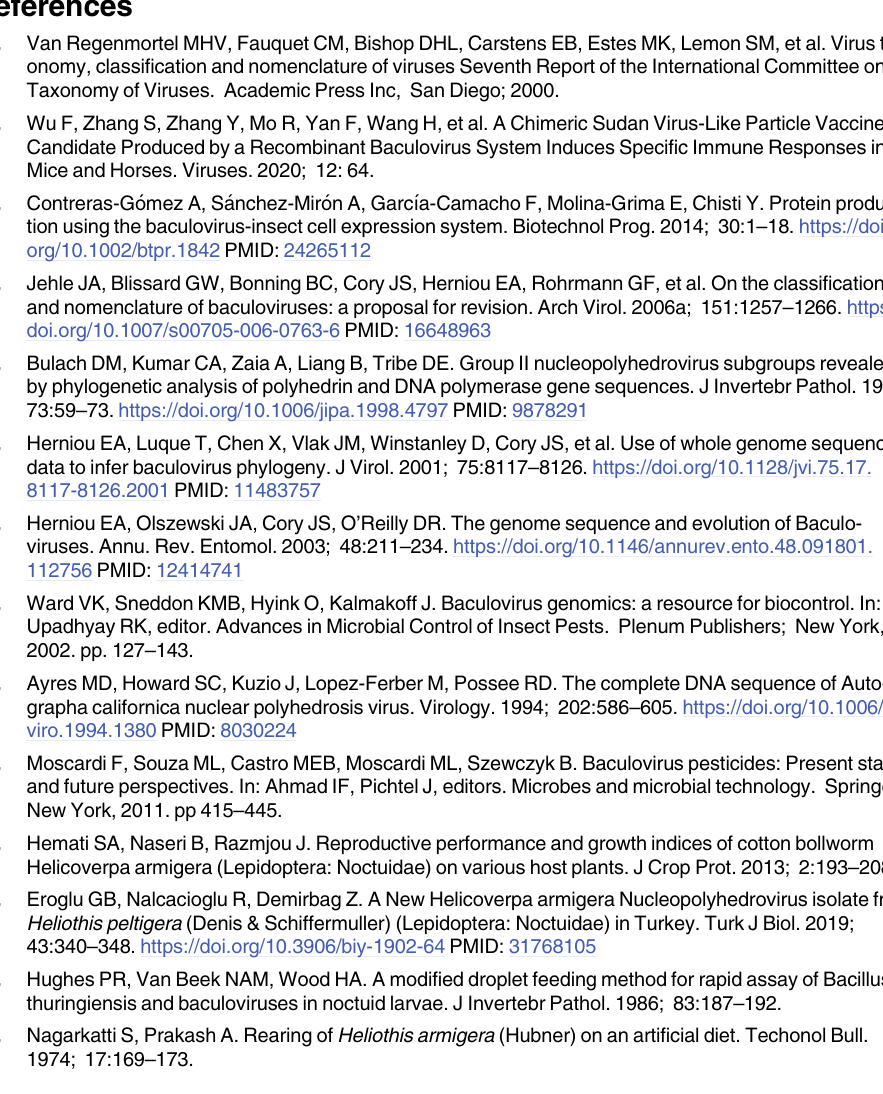
S4 Table. Open reading frames (ORFs) and properties of the HearNPV-TR